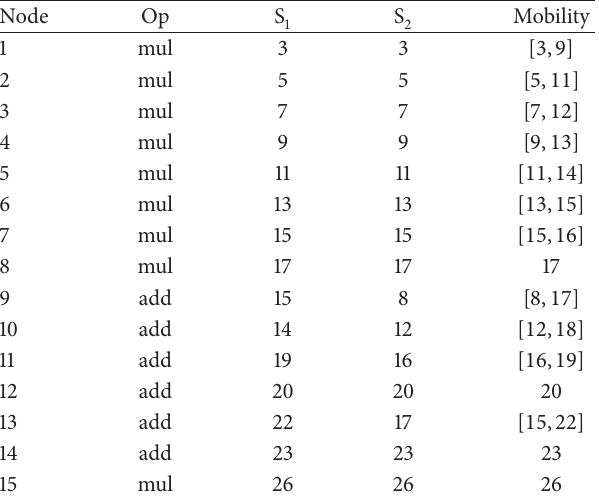
Table 1: Two schedules of